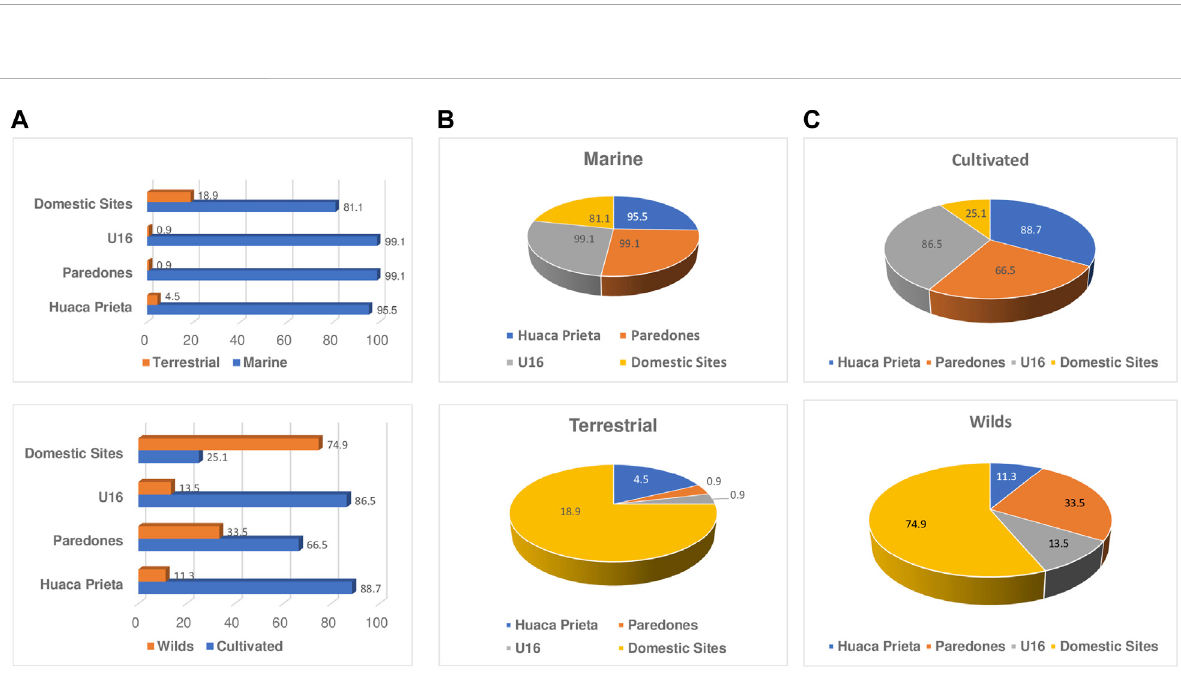
Bar-graphsandpie-chartsshowingpercentagesofmarine,terrestrial(wildplantsandanimalsinwetlands)andcultivatedcropsatritualmounds (Huaca Prieta and Paredones) and domestic sites (Unit 16 or U16 near Hiuaca Prieta and outlying domestic